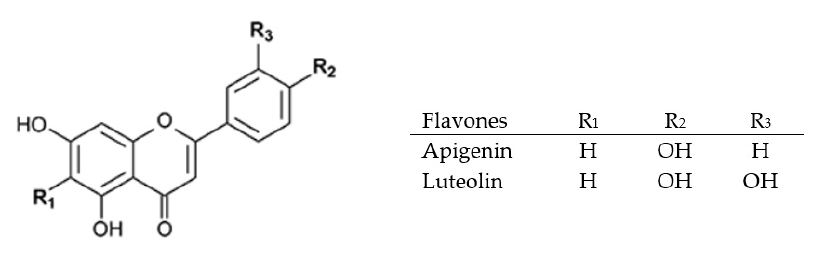
Figure 7. Structure of flavones [158].